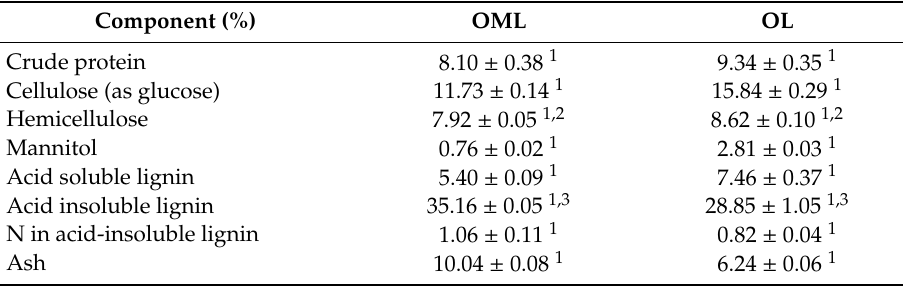
Table 1. Chemical composition of olive mill leaves (OML) and olive leaves (OL) 1